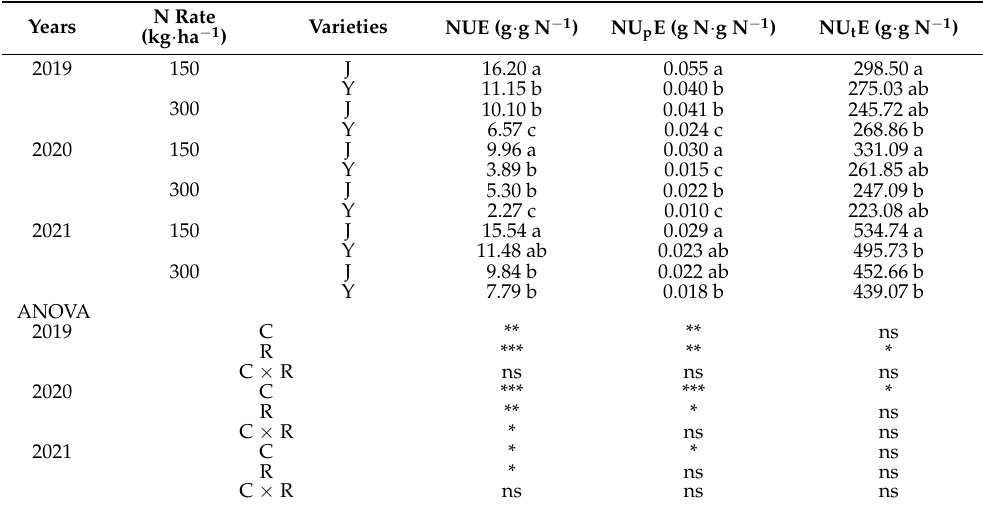
Table 3. NUE, NUpE and NUtE of two potato varieties at different nitrogen application